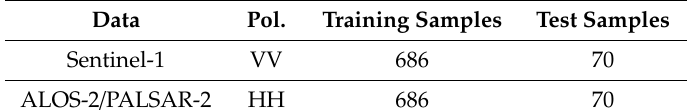
Table 7. Basic information on training samples and test samples.